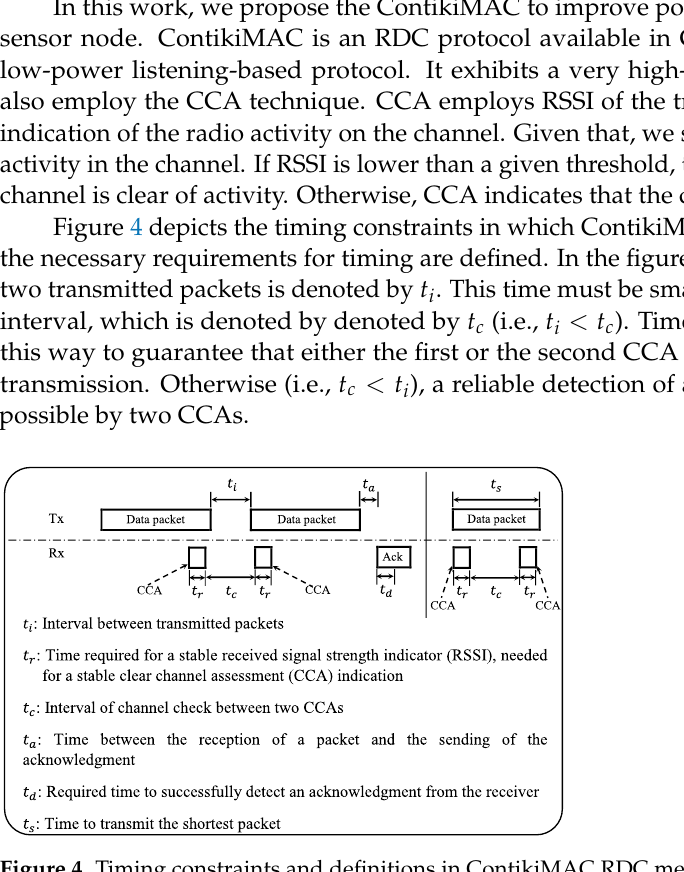
Figure 4. Timing constraints and definitions in ContikiMAC RDC